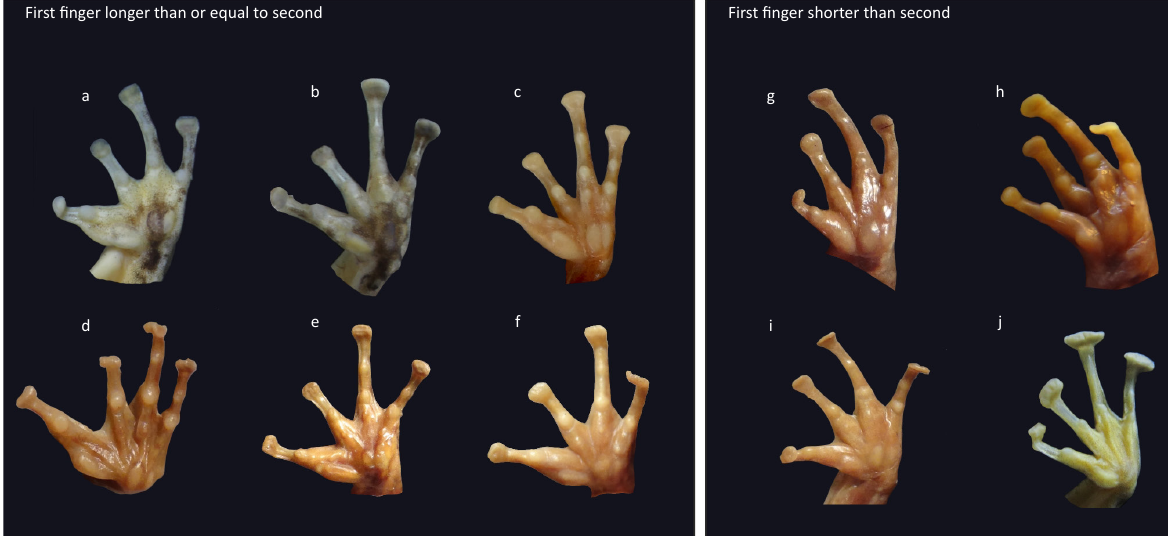
Image 4. Palms of different species of Indirana showing the distinction between first finger longer than or equal to second and first finger shorter than second. (a) Indirana chiravasi sp. nov. holotype, (b) I. chiravasi sp. nov. female paratype, (c) I. gundia Holotype (MNHN 1985.0633), (d) I. semipalamata syntype (BMNH 1947.2.29.50), (e) I. beddomii syntype (BMNH 1947.2.27.72), (f) I. brachytarsus Paralectotype (BMNH 1947.2.2.85), (g) I. diplosticta Syntype (BMNH 1947.2.2.21), (h) I. phrynoderma Syntype (BMNH 1947.2.3.8), (i) I. leptodactyla syntype (BMNH 1947.2.29.40) and (J) I. leithii topotype (uncataloged). Photo credit: (a-b) Neelesh Dahanukar, (c-i) Nikhil Modak and (j) Anand Padhye.